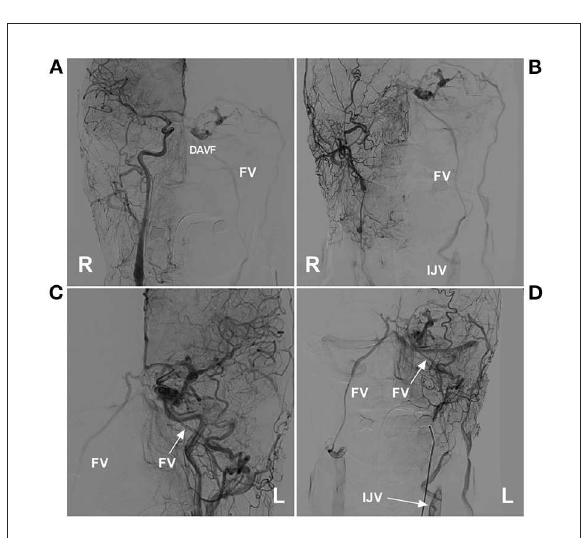
FIGURE6 Preoperative angiography of CS-DAVF embolized via the trans-IJV-FV-SOV route. (A, B) Right ICA (A) and ECA (B) angiographies show the dural branches of the ICA and ECA supplied to the DAVF in the right CS. The left FV served as the draining vein into the IJV. (C, D) Left ICA (C) and ECA (D) angiographies show the dural branches of the ICA and ECA supplied to the DAVF. The bilateral FVs served as the draining veins. CS, cavernous sinus; DAVF, dural arteriovenous fistula; ECA, external carotid artery; FV, facial vein; ICA, internal carotid artery; IJV, internal jugular vein; L, left; R, right; SOV, superior ophthalmic vein.